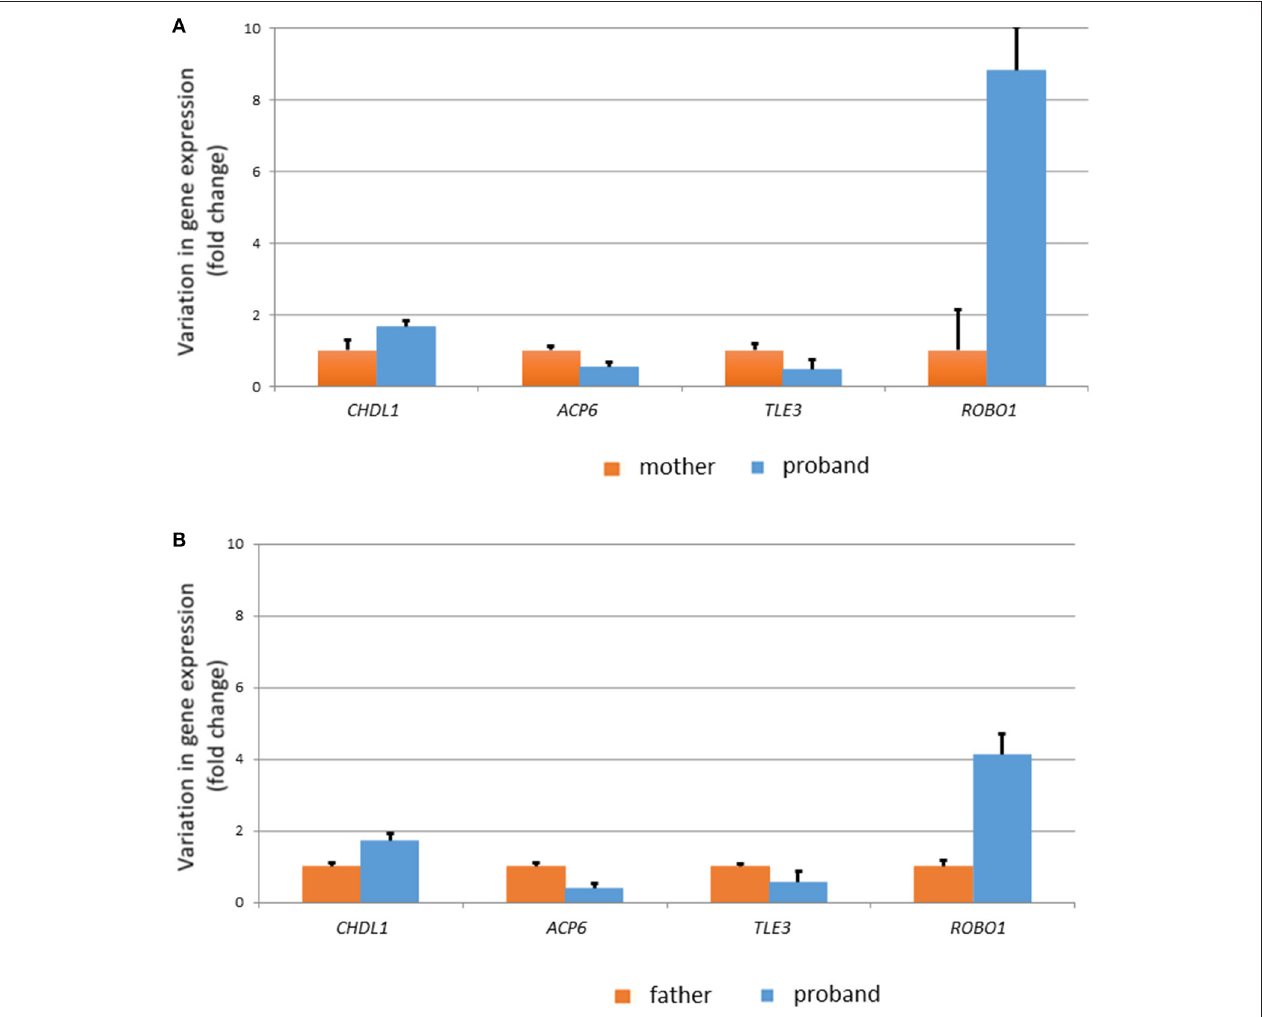
FIGURE 6 | Expression profile of genes of interest in the blood of the proband. Only the genes showing significant ( p < 0.05) differences with his healthy carrier mother (A) and his healthy non-carrier father (B) are displayed. Variation in gene expression levels is expressed as fold